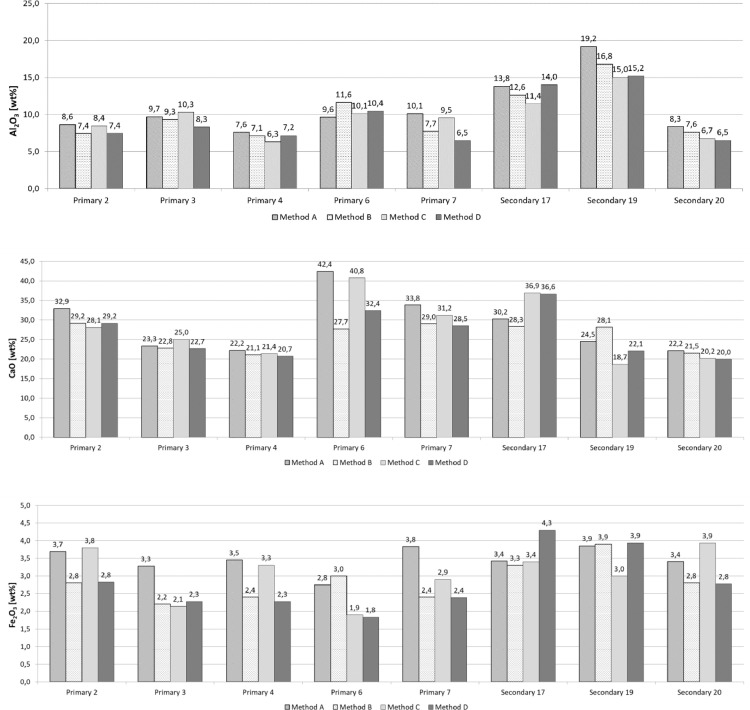
Results for Al2O3, CaO and Fe2O3 and for all analytical methods for randomly selected samples.